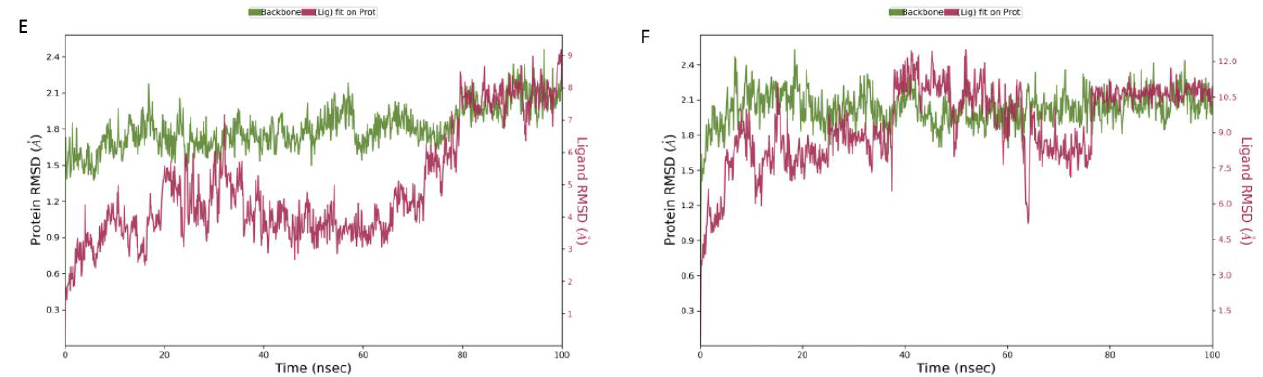
Figure 3. Root mean square deviation (RMSD) graphs for the top hit compounds: ( A ) olsalazine, ( B ) phenytoin catechol, ( C ) phlorofucofuroeckol, ( D ) inosine, ( E ) eckol and ( F ) valganciclovir. The green graph shows the fluctuations in the protein backbone from the initial reference point, while the red shows the ligand fluctuations. The RMSD profile of the ligand is with respect to its initial fit to the protein binding pocket indicates that all ligands did not fluctuate beyond a 2–4 Å range for the majority if the simulation period.